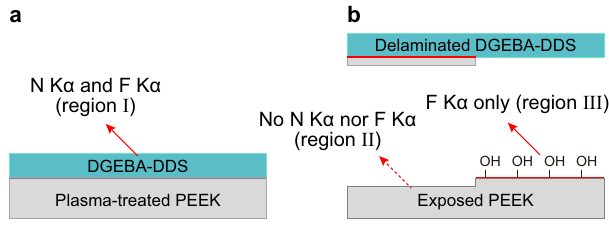
Fig. 3 Schematics of the adhesion failure determined by XRF imaging. a Presence of DGEBA-DDS. Both the N K α and F K α signals were observable in region I. b In region II, neither N K α nor F K α signals were observable due to the substrate failure. In region III, only the F K α signal was observable due to the interfacial